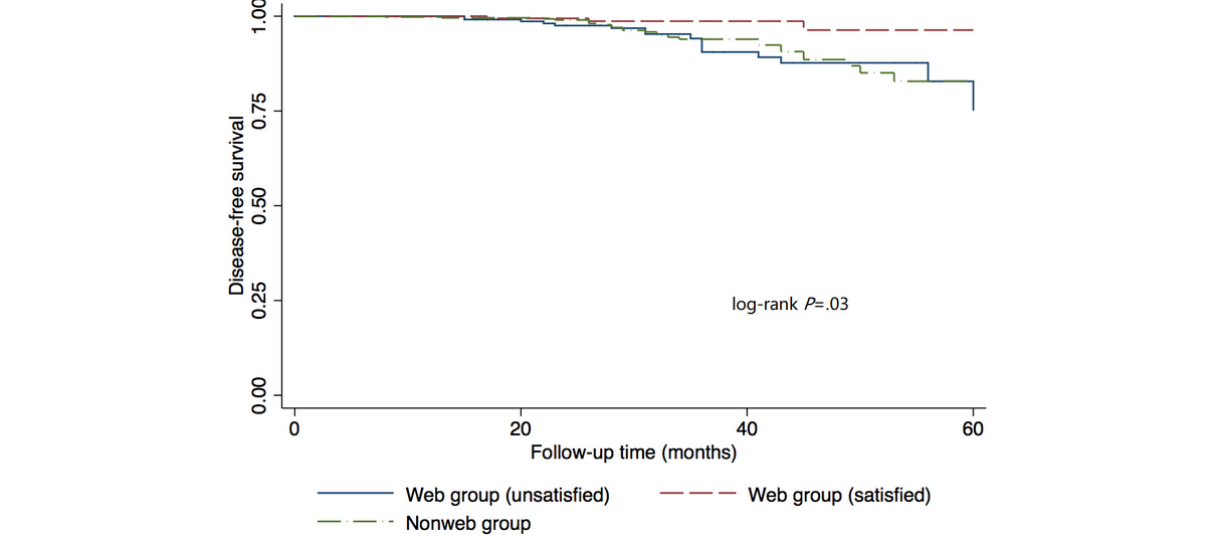
Figure 2. Kaplan-Meier survival curves of disease-free survival (DFS) according to web usage and satisfaction level of internet information.